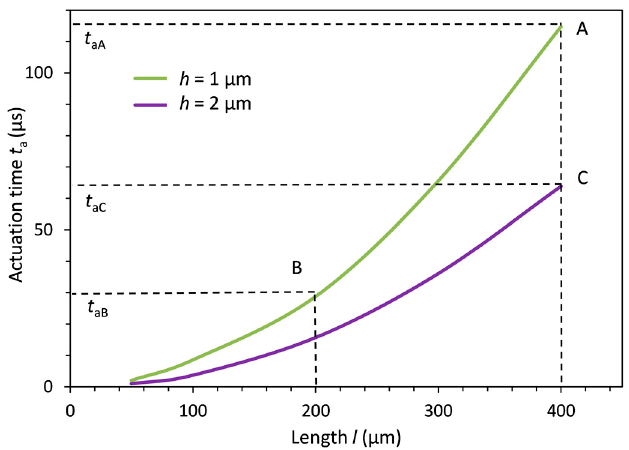
Figure 14. Variation of the actuation time t a with length l and thickness h for Al MEMS cantilevers.